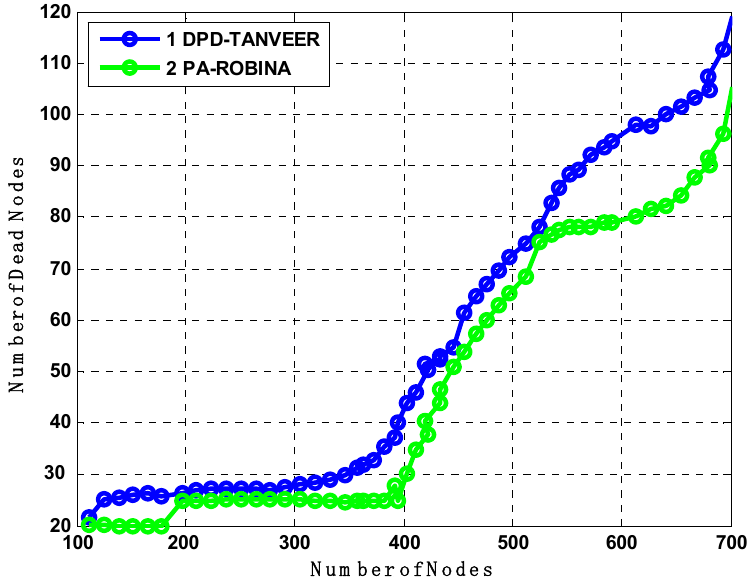
Figure 13. Analysis of the number of dead nodes compared with DPD-TANVEER.